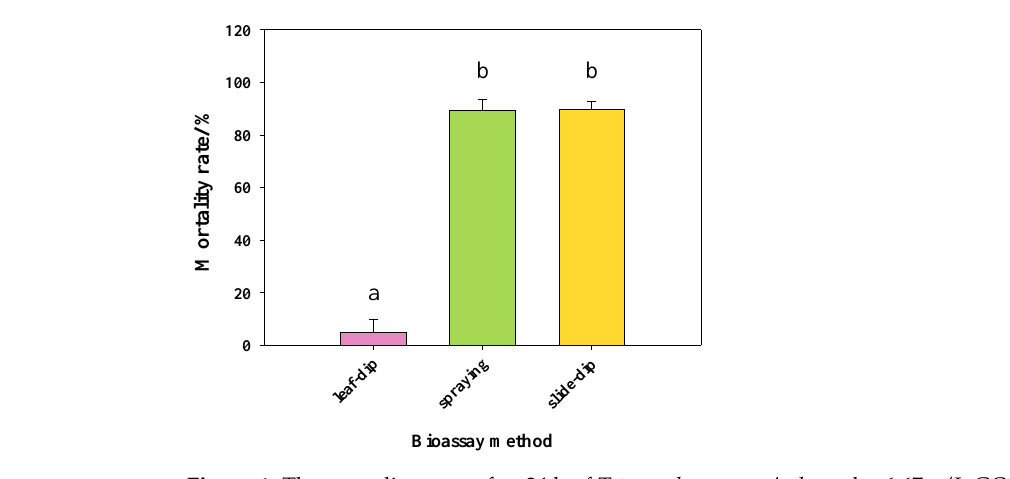
Table 2. Poisoning symptoms after the GC16 treatment.